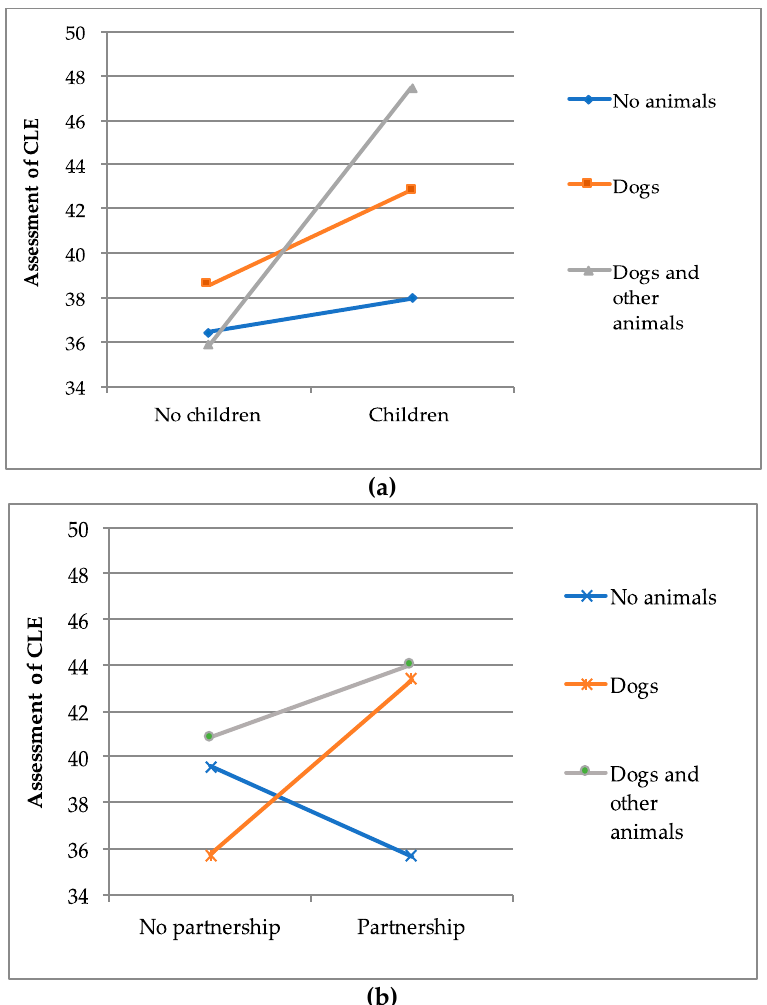
Figure 3. Interactions between inner- ( a ) and cross-species ( b ) relationships regarding the assessment of normative stressors. of normative